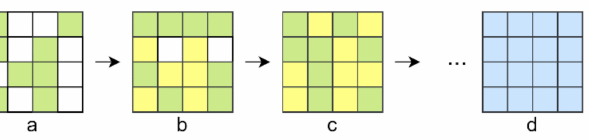
Figure 2. PA principle: ( a – c ) random selection of half the segments and phase setting with random values in between 0–2 π ; ( d ) final optimized phase map. This scheme shows phase optimization for 4 × 4 format (based on